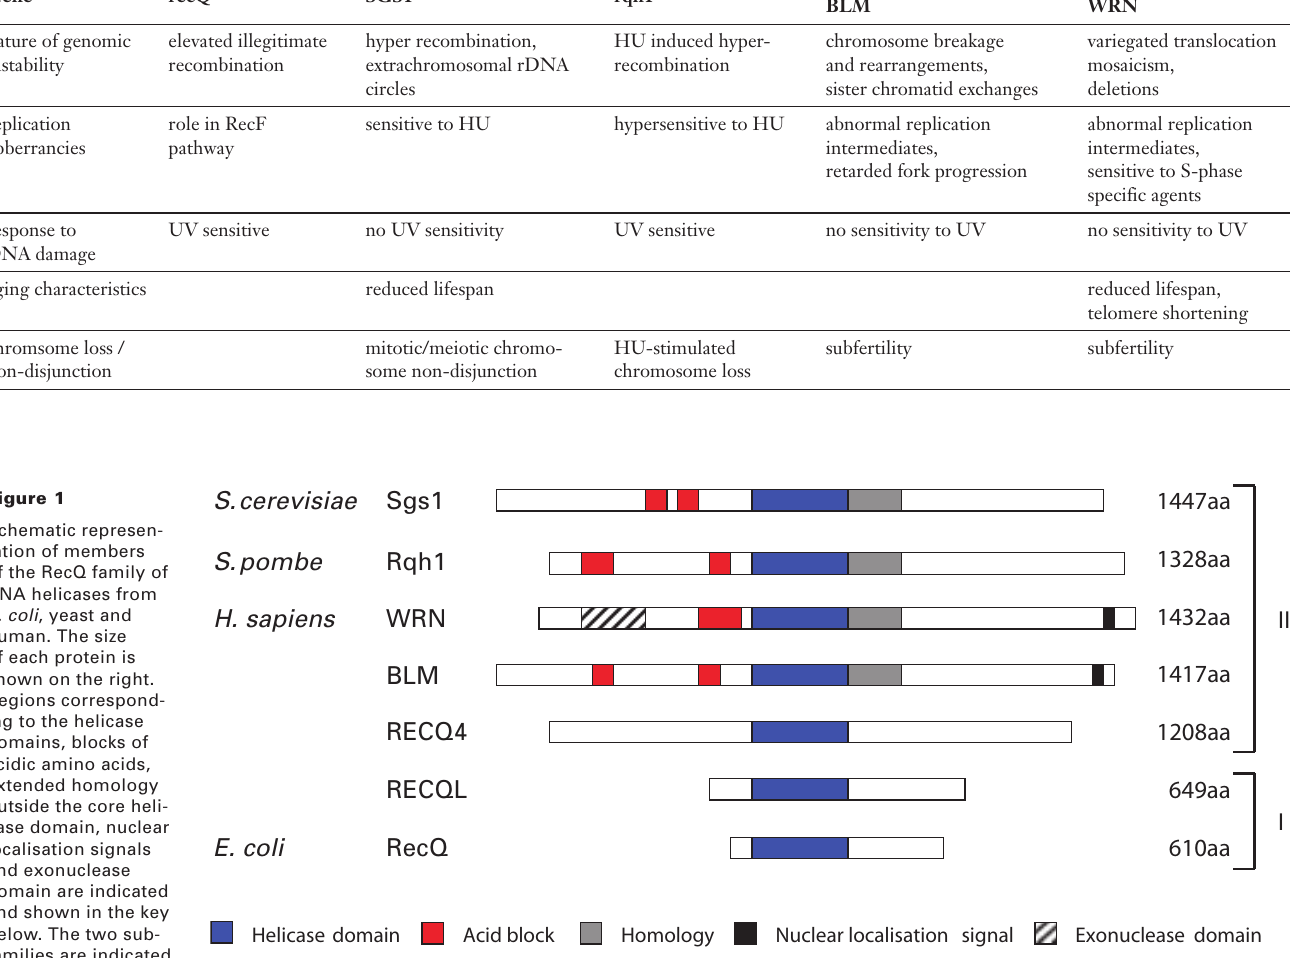
Table 1 Phenotypes associated with mutants lacking a RecQ family